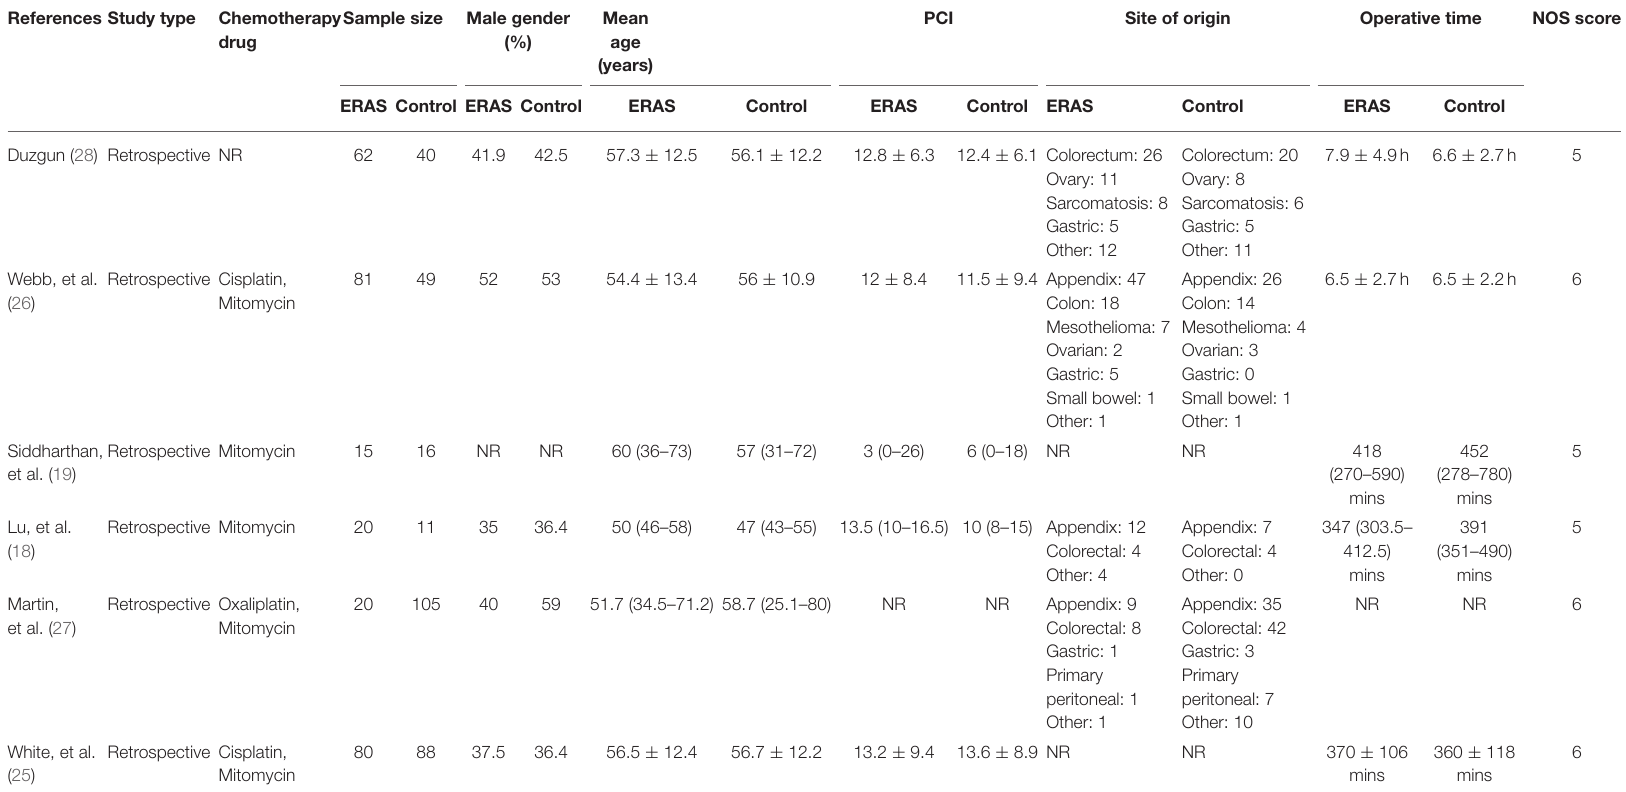
TABLE 1 | Details of included